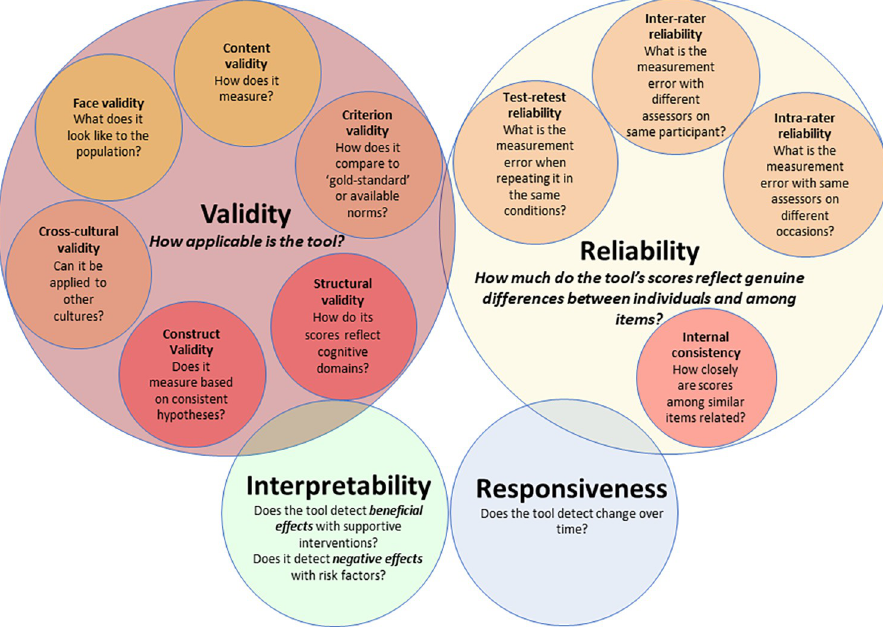
Fig 2. Assessing the measurement properties of a tool. Domains of psychometric properties adapted from the following publication: Mokkink LB, Terwee CB, Knol DL, Stratford PW, Alonso J, Patrick DL, et al. The COSMIN checklist for evaluating the methodological quality of studies on measurement properties: A clarification of its content. BMC Medical Research Methodology. 2010;10(1):22.